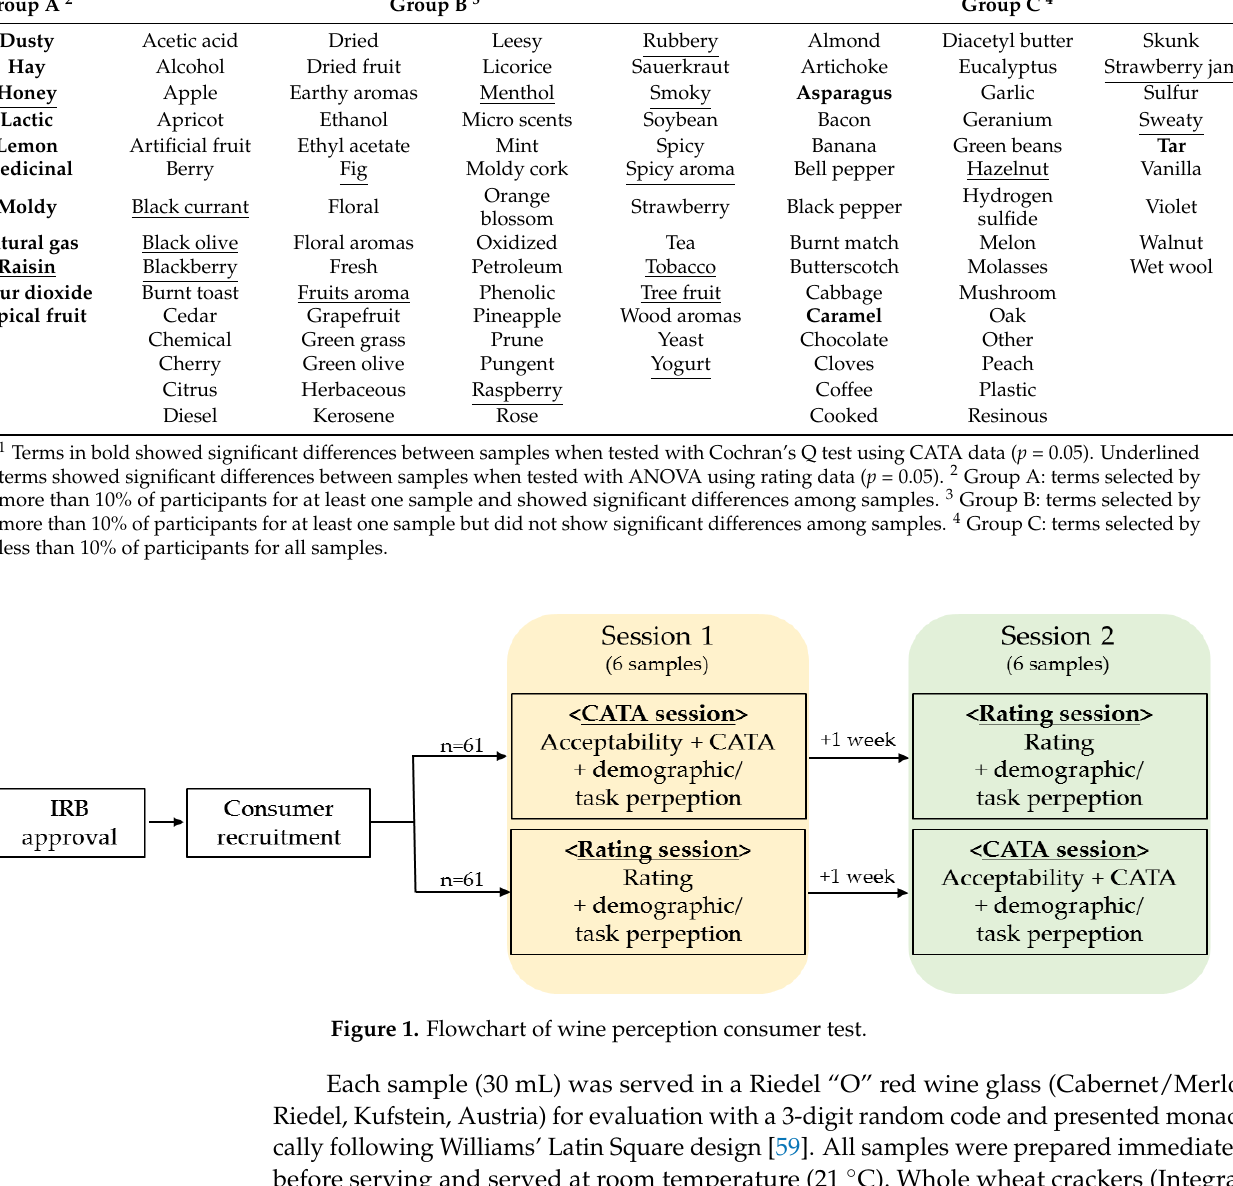
Table 2. Terminology of 108 wine characteristics used in the check-all-that-apply (CATA) and rating questionnaires 1 . Group A 2